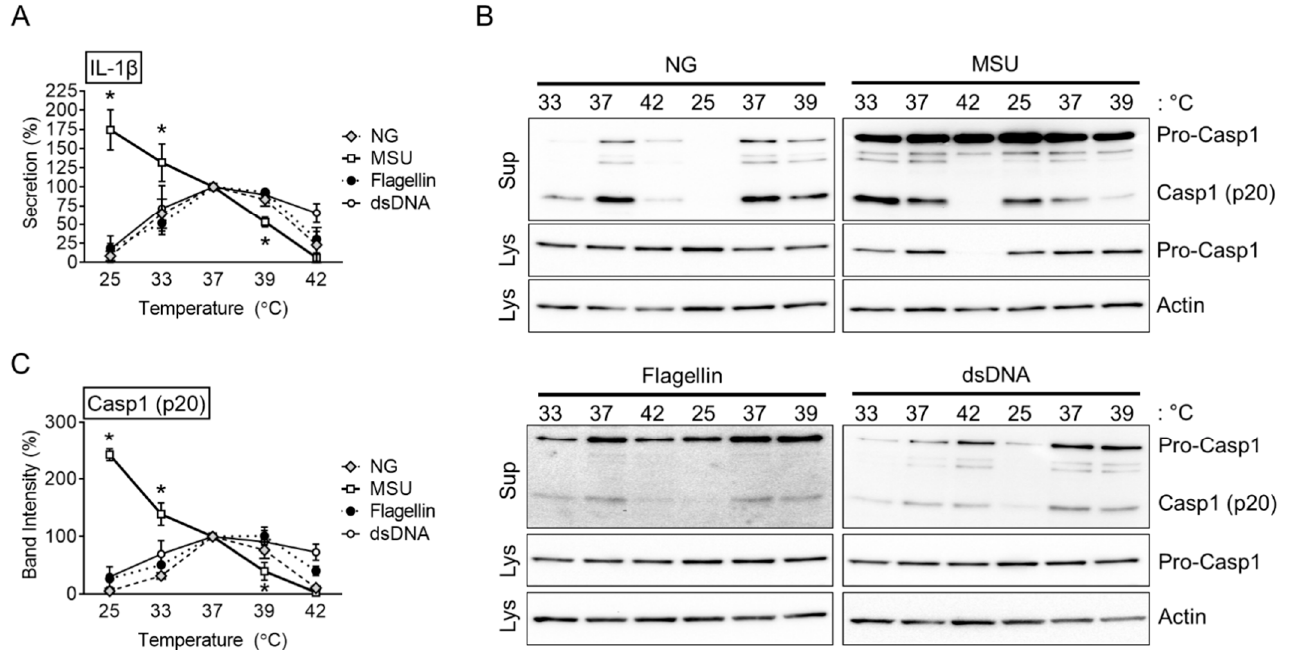
Figure 1. Effects of various temperatures on inflammasome activation. LPS-primed BMDMs were treated with NG, MSU, flagellin, or dsDNA at 25, 33, 37, 39, or 42 ◦ C. ( A ) IL-1 β secretion of the BMDMs was measured by ELISA. IL-1 β secretion at 37 ◦ C by each trigger was set as 100%, and the graph was drawn. ( B ) Casp1 (p20) secretion was analyzed by immunoblotting. ( C ) The relative intensity of Casp1 (p20) bands are presented as a graph. The graphs present the mean ± standard deviation (SD) of at least two independent experiments, and immunoblotting images are representative of two independent experiments. * p < 0.05 vs. NG, flagellin, and dsDNA.